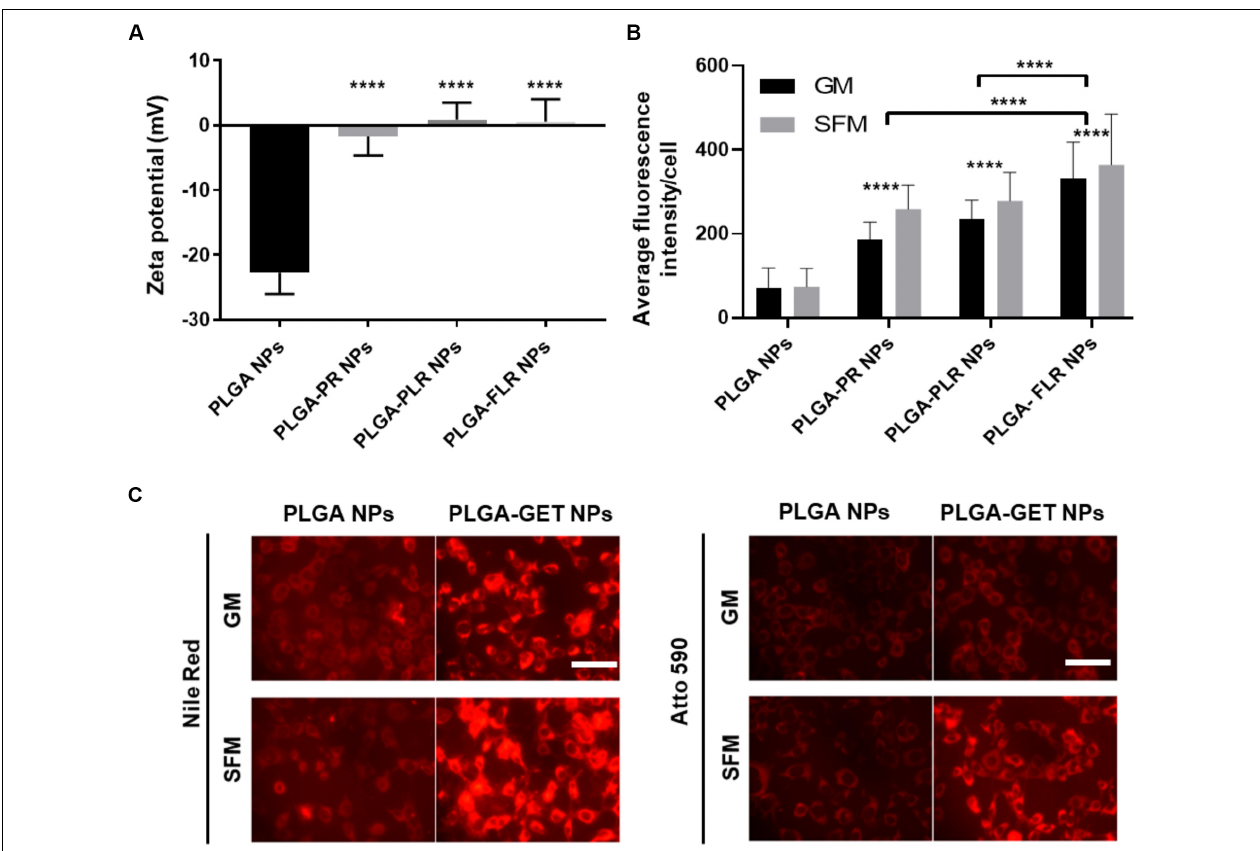
FIGURE 3 | Enhanced delivery of PLGA NPs with GET peptides. (A) Interaction between GET peptides and PLGA NPs (Blank and pDNA-encapsulated) and confirmation of PLGA-GET complex formation through a shift in the surface charge of PLGA NPs measured by Zetasizer. (B) All variants of GET peptides enhance the delivery of PLGA NPs significantly in comparison to non-complexed PLGA NPs. PLGA-FLR NPs are associated with the highest levels of uptake followed by PLGA-PLR NPs quantified by flow cytometry analysis. (C) Fluorescence microscopy images of NIH3T3 cells after addition of Nile Red-, Atto590-encapsulated PLGA NPs with and without GET peptide complexation in 10% FCS containing media (Growth media, GM) or SFM. The peptide significantly enhances the PLGA NPs, especially in SFM. Scale bar 100 µ m. The asterisk over the bars indicate significance to control (PLGA NPs), the asterisk over the lines indicate significance between groups. One-way and two-way Anova statistical analysis was used to generate the graph followed by Tukey test to determine significant differences between each mean. The data represented as mean ± SD. P -value were <